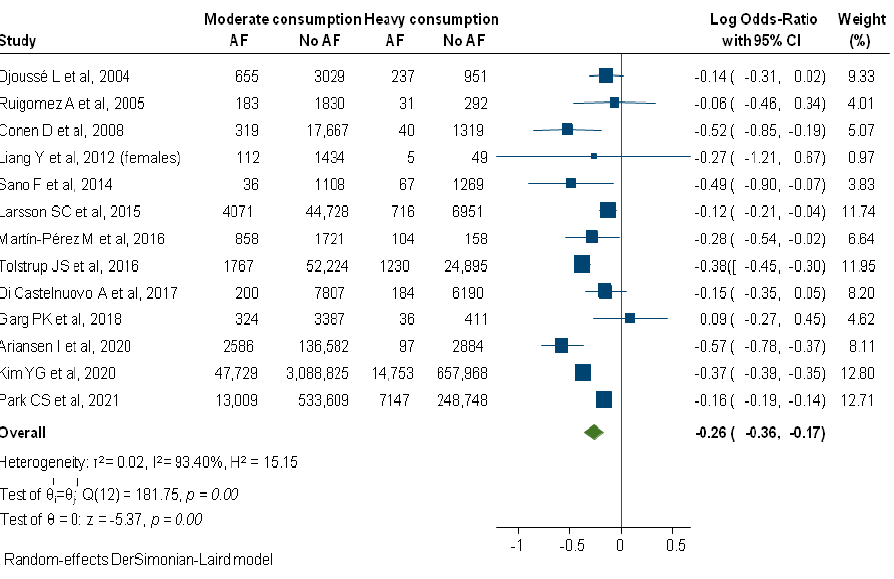
Figure 4. Comparison between moderate and heavy alcohol consumption regarding incident AF. AF, Atrial Fibrillation.